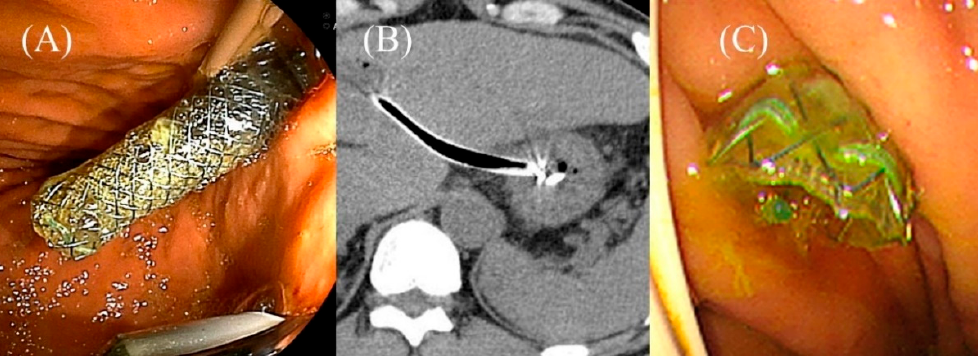
Figure 17. Impending delayed migration in Niti-S S-type stent (Taewoong Medical). A sufficient length of the gastric end of the stent is seen after the procedure ( A ). The next day’s CT shows that the intragastric stent length has shortened ( B ). Urgent endoscopy reveals impending migration of the gastric end of the stent ( C ).